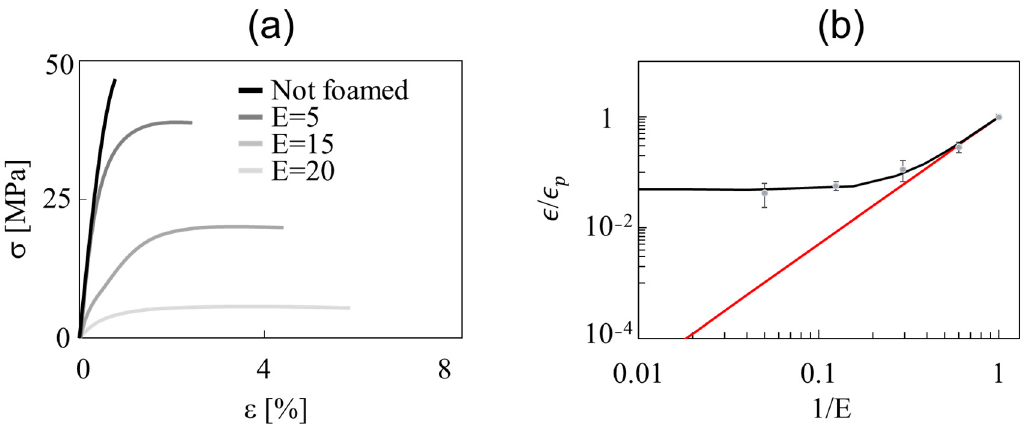
Figure 4. ( a ) Tensile stress as a function of percent deformation for 4 foamed strands at increasing E (see legend); ( b ) Ratio of foam and polymer elastic moduli as a function of the inverse of the expan- sion ratio. The red line is the best fit of the data at high 1/ E through the power law proposed by Egli et al. [4]; the black curve is the best fit of the data through Equation (1).